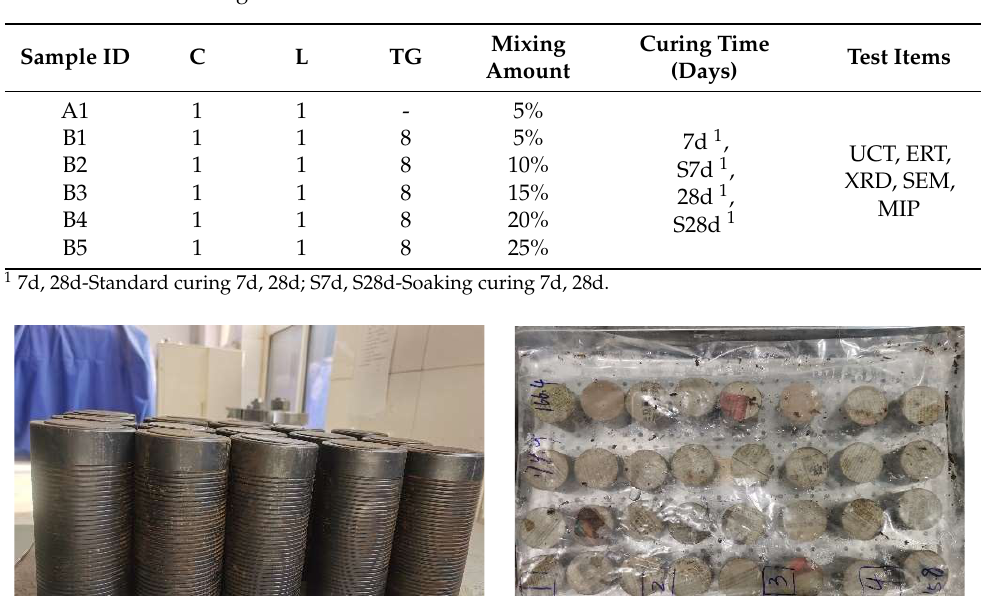
Table 4. Schematic design.